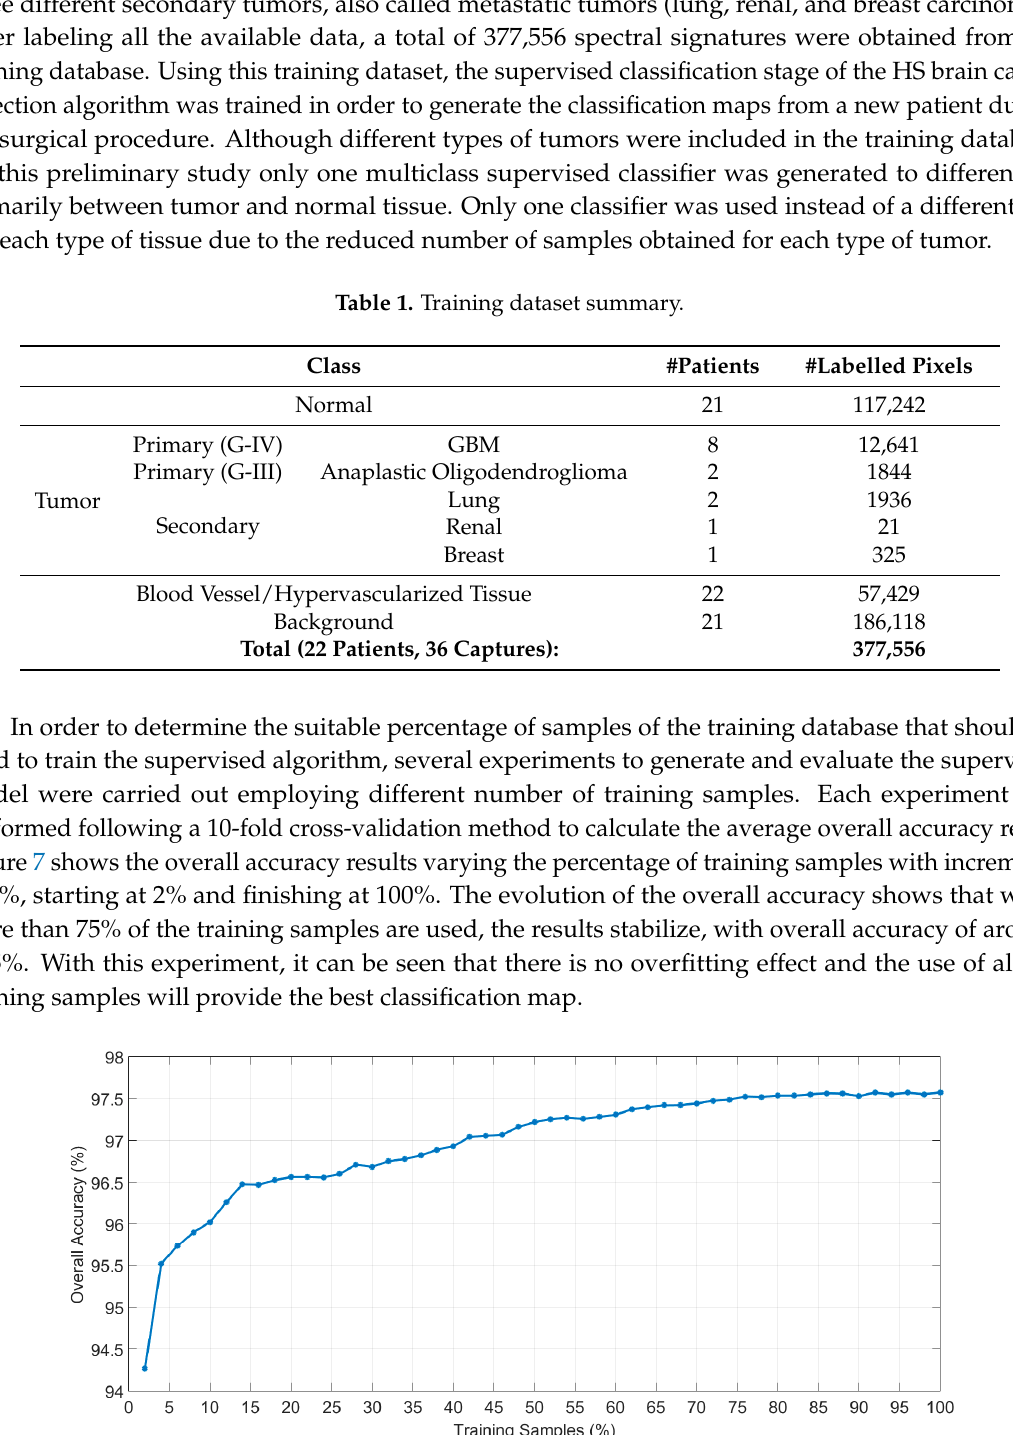
Table 1. Training dataset summary.